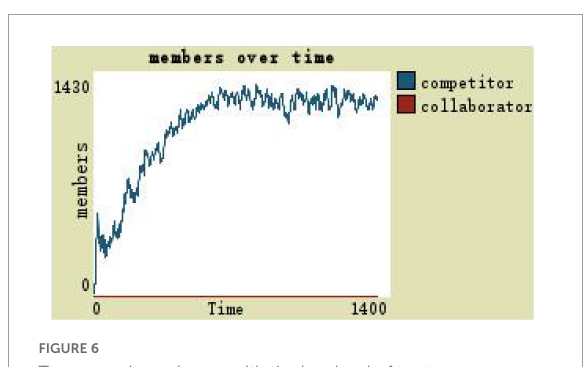
FIGURE3 Team members change at the initial values.